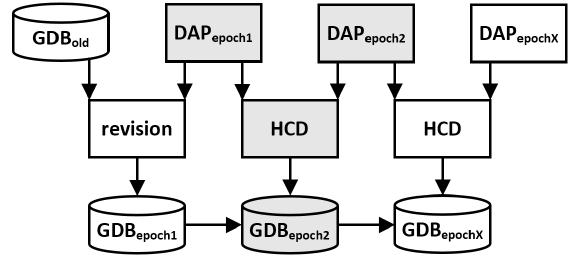
Figure 2. Permanent update model